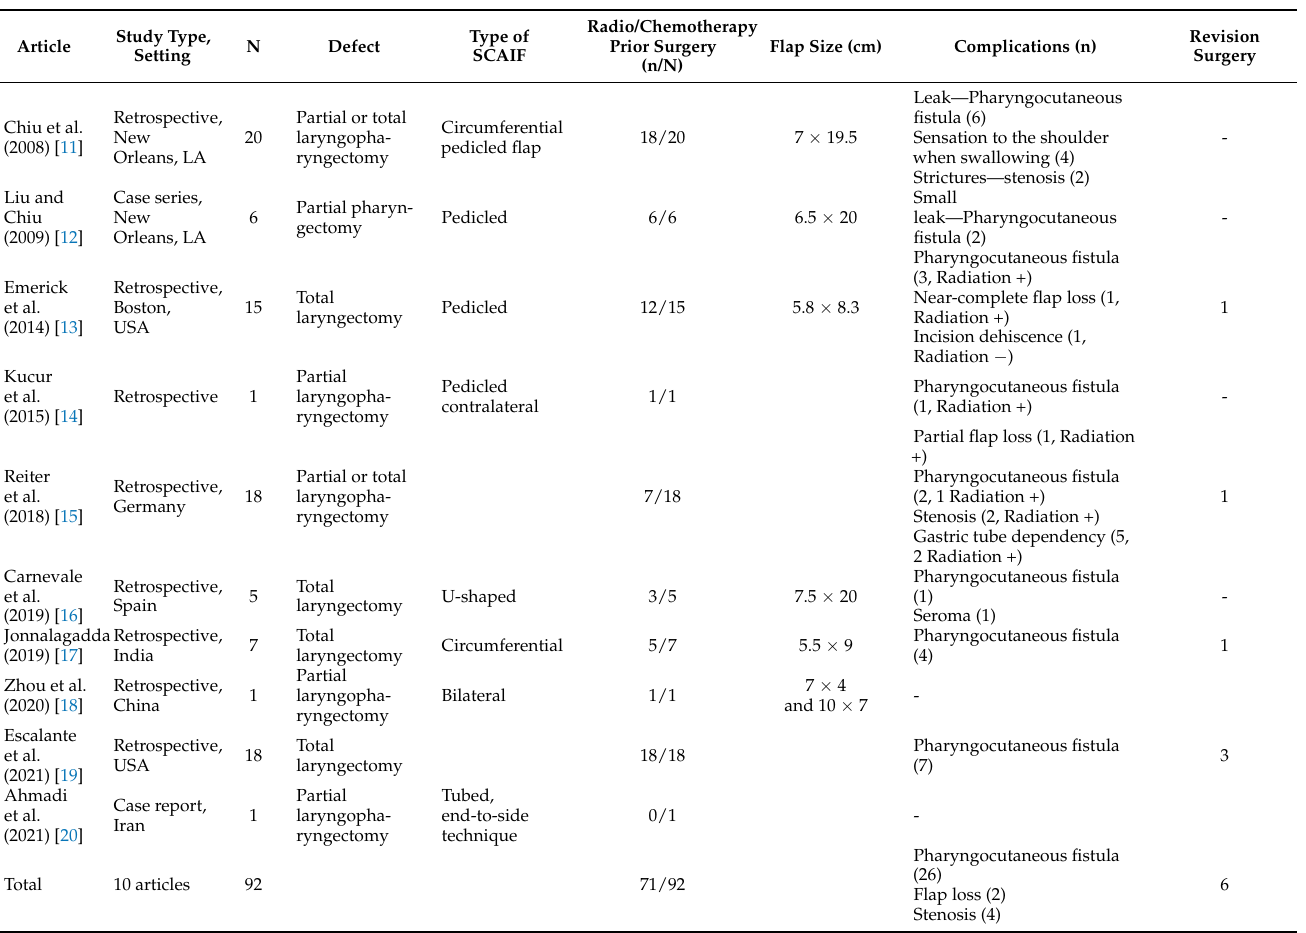
Table 2. Summary of included articles. (N = total number of patients, n = number of patients, SCAIF = supraclavicular artery island